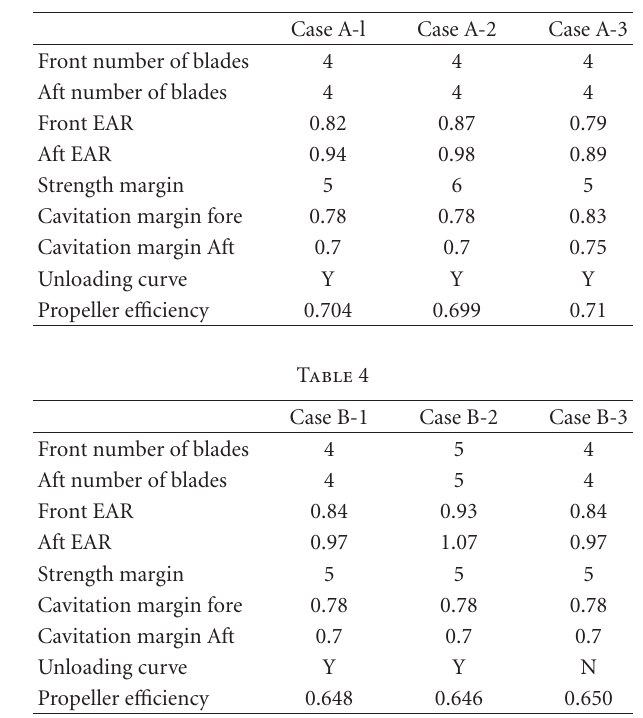
Table 3: Main characteristics of CR propellers used for the parametric